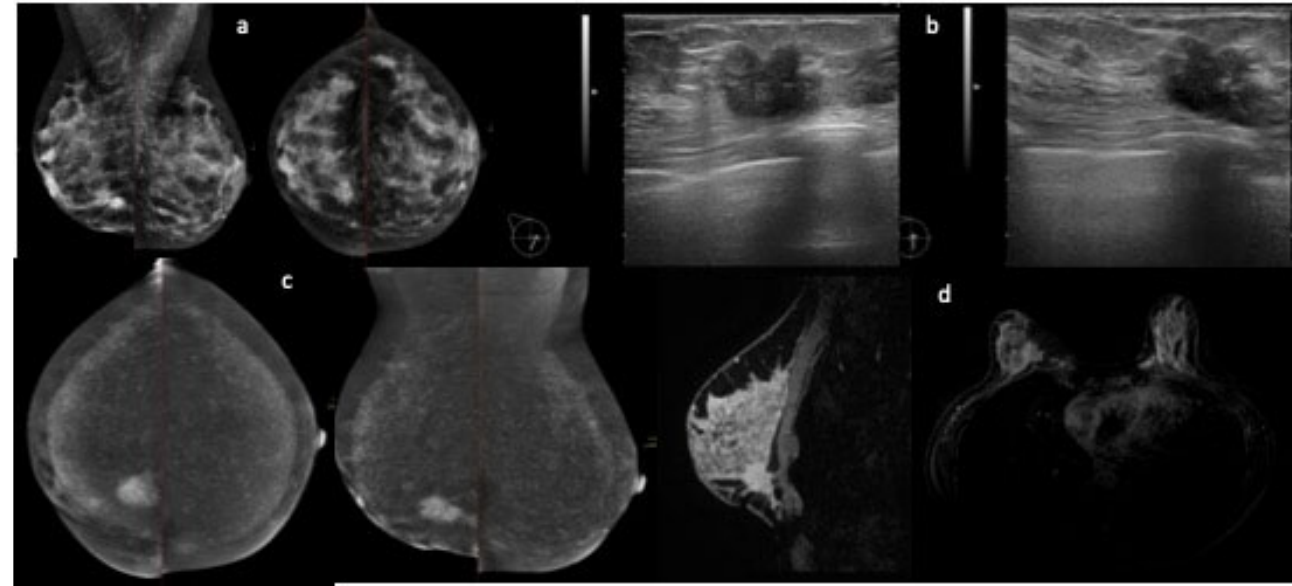
Figure 3. FFDM shows an irregular opacity in the inner lower quadrant of the right breast ( a ); US images show an irregular hypoechoic nodule in the inner lower quadrant of the right breast, with some suspicious smaller images close to the bigger one ( b ). CESM images confirm an irregular contrast uptake nodule in the inner lower quadrant of the right breast ( c ). Compared to the MRI, the background enhancement is still present but milder ( d ).